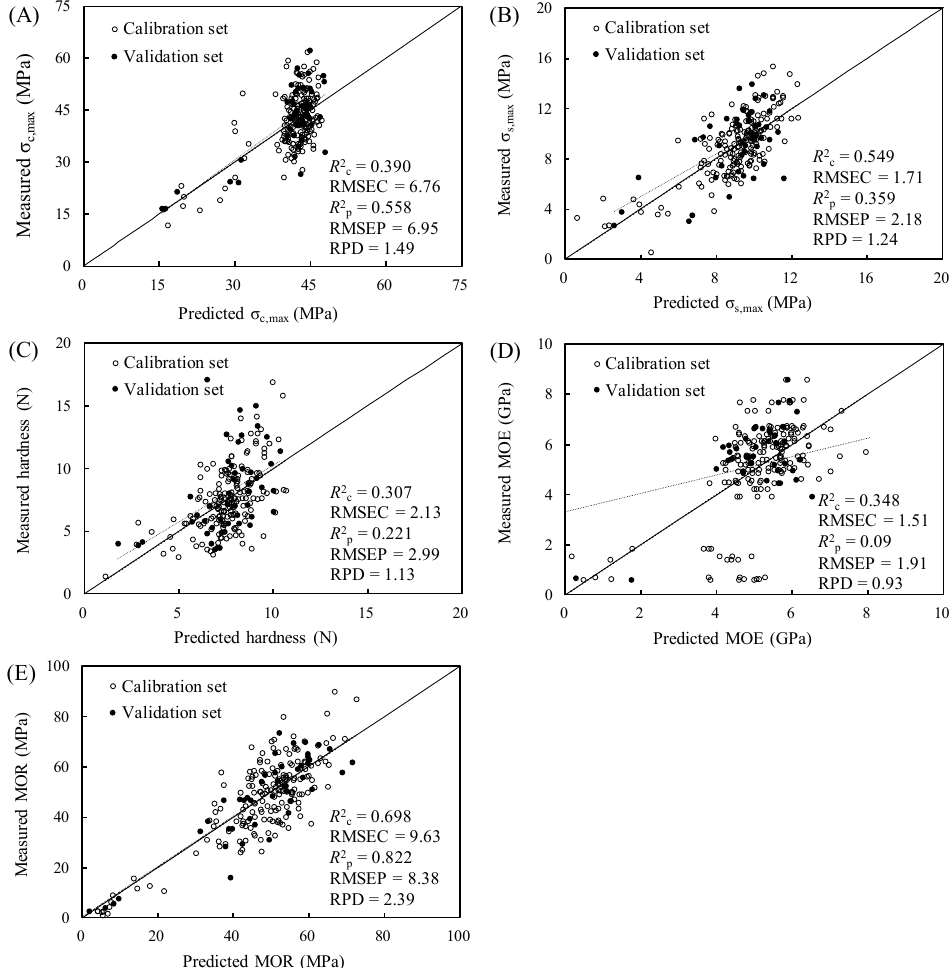
Figure 5. Correlation between the predicted and measured values of ( A ) σ c,max , ( B ) σ s,max , ( C ) hard- ness, ( D ) MOE, and ( E ) MOR.